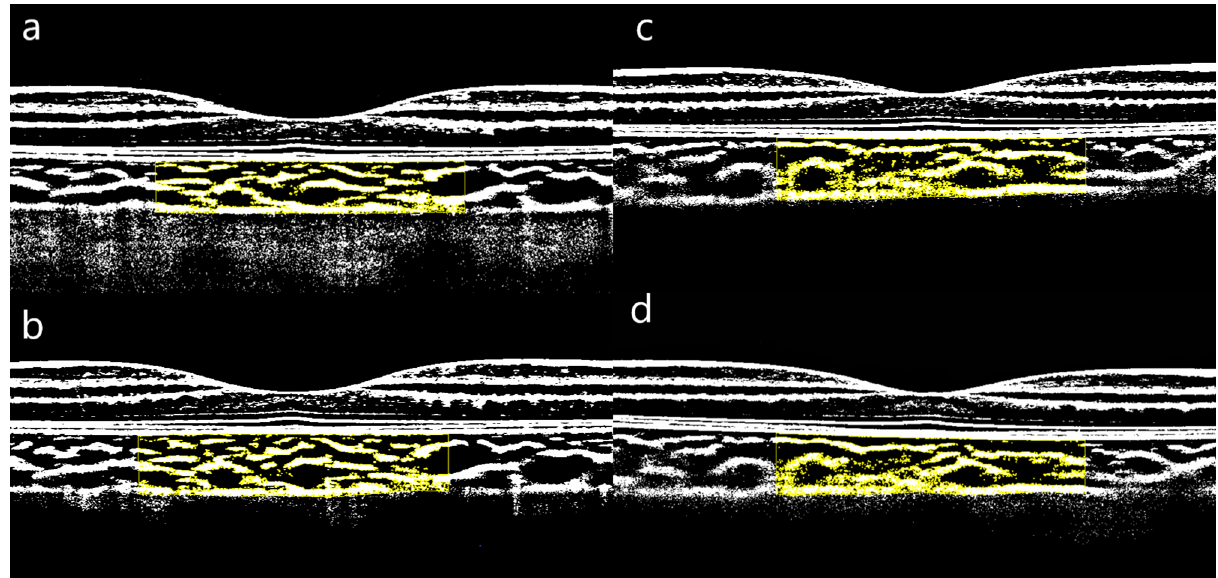
Figure 1. Binarized B scan images displaying the changes in CVI over time. Binarized B scan image of a patient in the Ortho-K group at baseline and week 1 of follow-up ( a , b ). The CVI was significantly increased by 2.51% from baseline compared to the 1-week follow-up. Binarized B-scan image of a patient in the control group at baseline and week 1 of follow-up ( c , d ). The CVI was reduced by